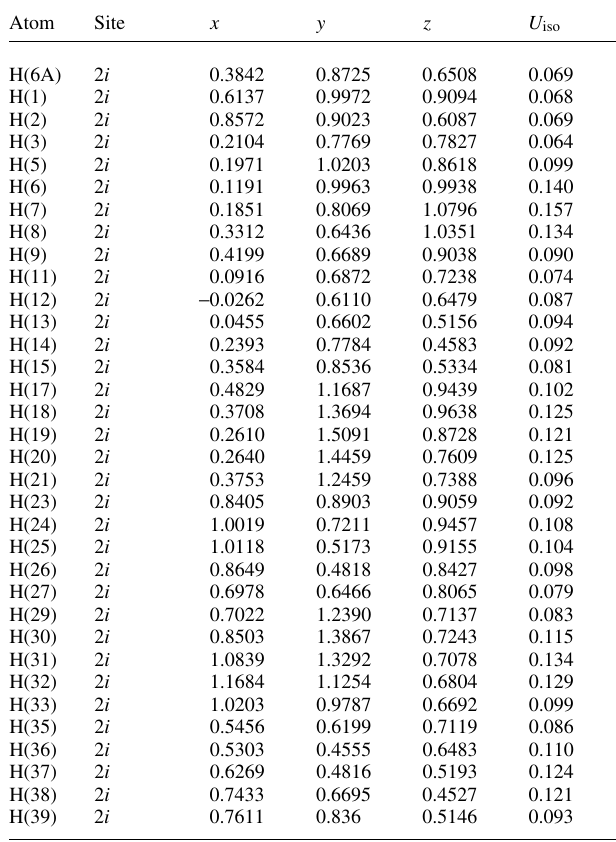
Table 2. Atomic coordinates and displacement parameters (in Å 2 )